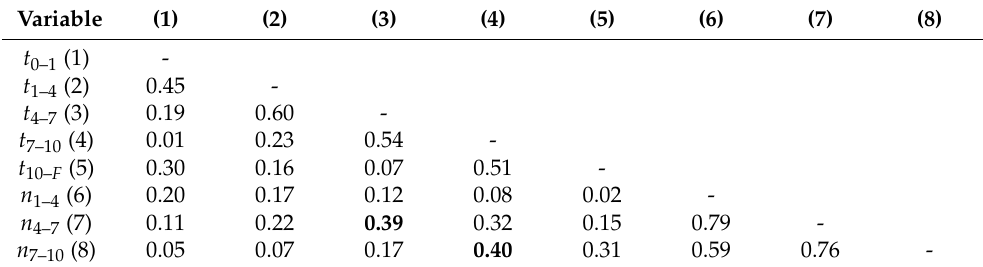
Table 6. Simple r-Pearson’s correlation coefficients between all variables.